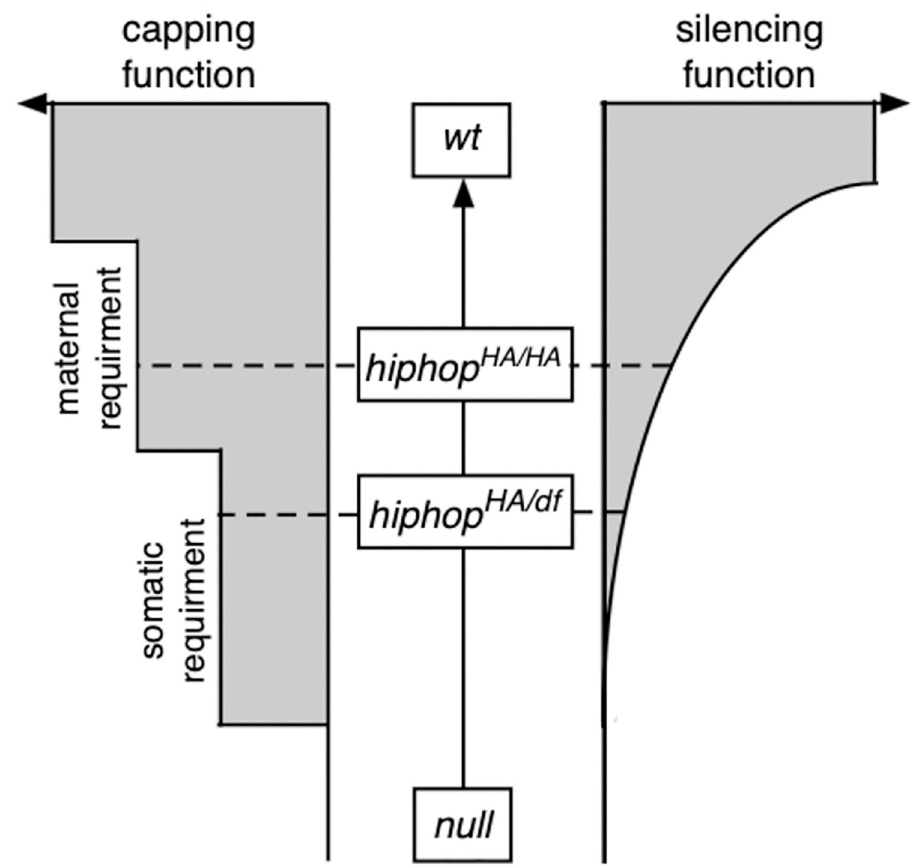
Fig 9. A speculative model for the intricate relationship between the capping and silencing functions of the capping machinery. The scale in the center represents the strengths of various hiphop mutant combinations from “ null ” to “ wt ”, with the deduced positions indicated for the hiphop HA/HA and the hiphop HA/df allelic combinations. The capping and silencing functions are shown to either side of the center scale as two horizontal scales. For the capping function, two thresholds of functional requirements have been identified: one for capping in early embryos that are controlled by the maternal hiphop genotype, and the other for capping during somatic development. For the silencing function, a continuous decline correlates with the strengths of different mutations. It is defined as lost (reaching zero) when viability of the mutants is no longer supported due to somatic uncapping. Depending on which function is more sensitive to the partial loss of HipHop functions, separation-of-function mutations would have different properties. This model assumes that the silencing function has a lower threshold of producing mutant phenotypes than one for